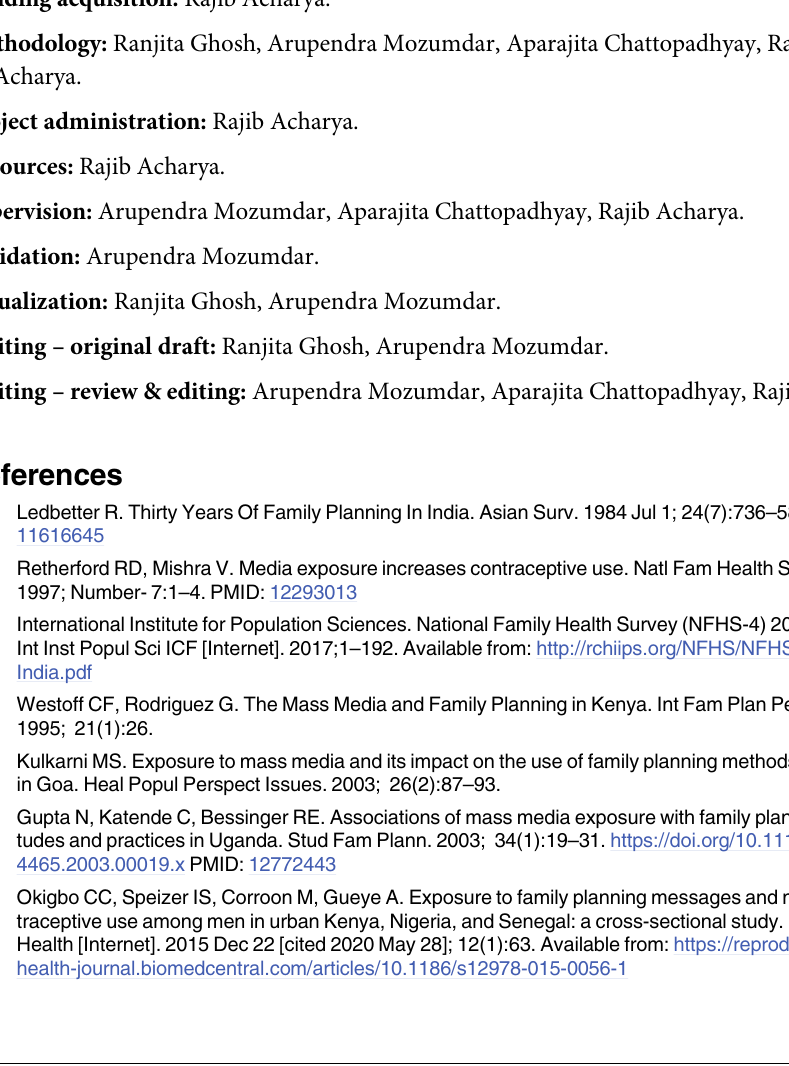
S1 Table. List of variables in the analysis and the recoded categories. S2 Table. Ownership of mass media and exposure to family planning messages on